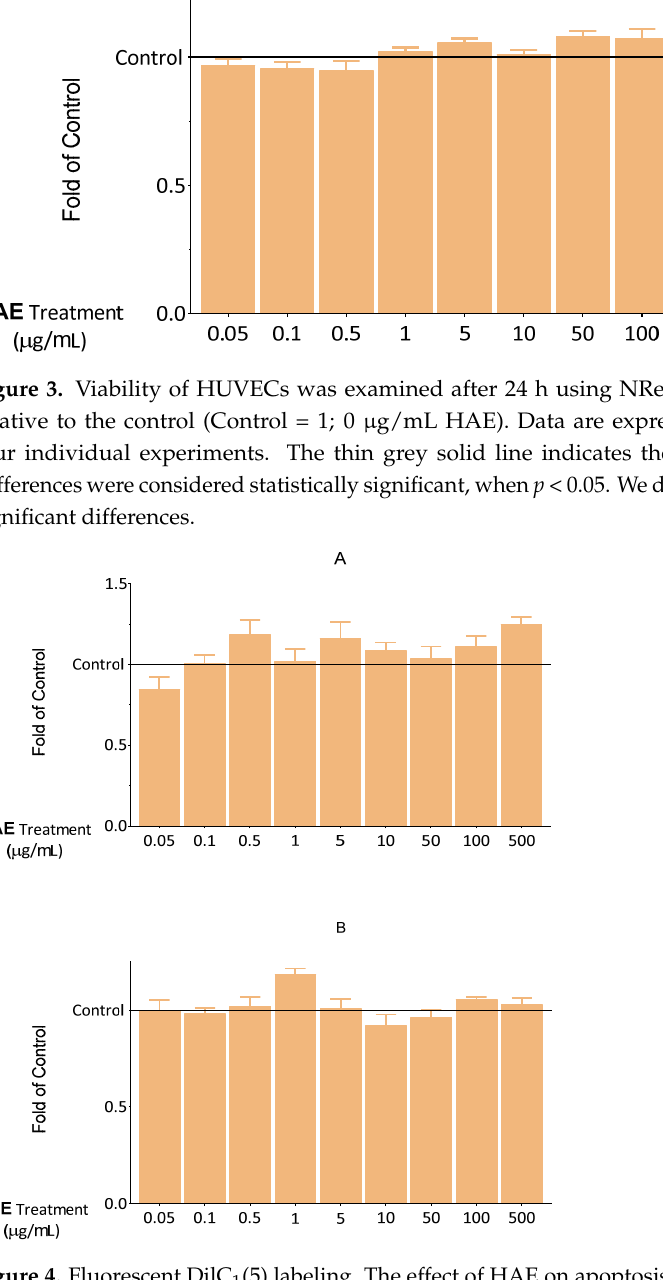
Figure 4. Fluorescent DilC 1 (5) labeling. The effect of HAE on apoptosis after 24 ( A ) and 48 ( B ) hours. The results are expressed relative to the control (Control = 1; 0 µg/mL HAE). Data are expressed as the mean ± SEM of four individual experiments. The thin grey solid line indicates the control level (Control = 1). Differences were considered statistically significant when p < 0.05. We did not observe any statistically significant di ff erences.